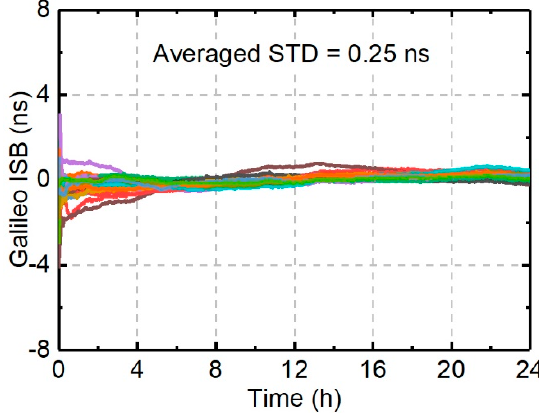
Figure 4. One day (3 September 2019) ISB series for Galileo.